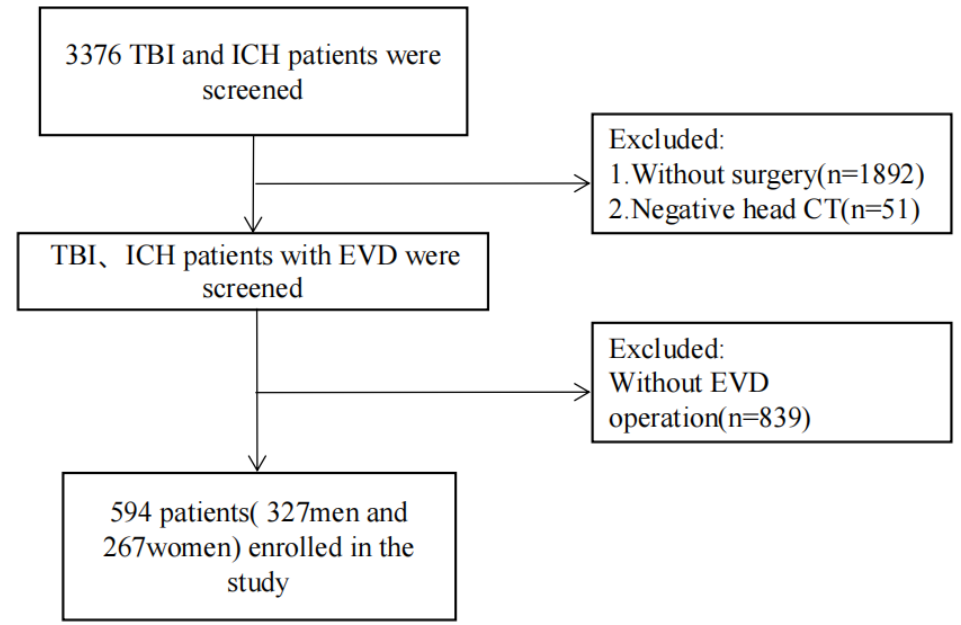
Figure 1. Flow chart for identifying eligible patients. Abbreviations: TBI, traumatic brain injury; ICH, intracranial hemorrhage; CT, computerized tomography; EVD, external ventricular drainage.